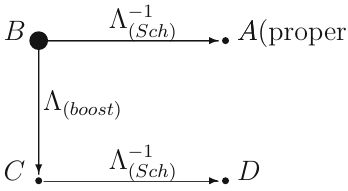
Fig. 1 A schematic representation of various pairs of the tetrad and spin connection in the static gauge. The bold dot represents the initial tetrad (4.3) in which we “switch off” gravity